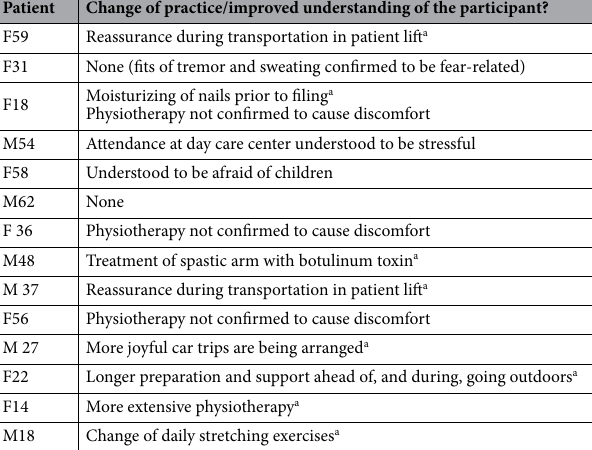
Table 3. Results of HR monitoring. For 12 of the 14 non-communicating patients with ID in this study, HR monitoring led to an improved understanding of their preferences, stressors, and dislikes. For eight participants ( a ) there was a change in caregivers’ practice after HR